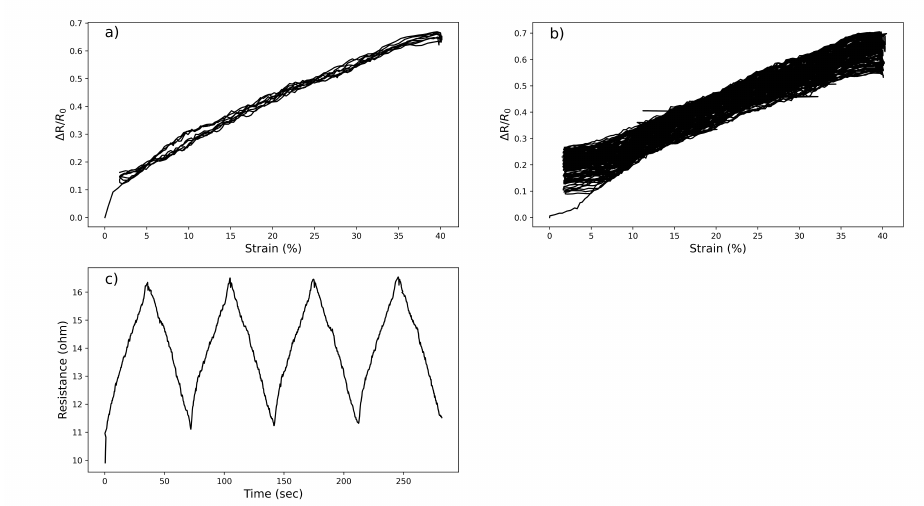
Figure 3. The developed knitted strain sensor graphs under four cyclic tests, ( a ) Relative resis- tance change versus strain, ( b ) Relative resistance change versus strain for 70 repetitive cycles, and ( c ) Resistance changes versus time at a strain 40% strain under 4